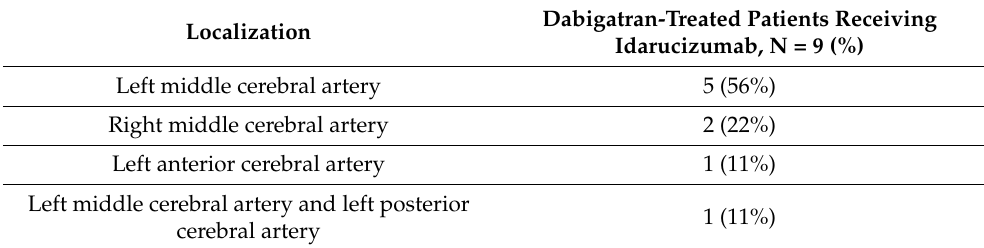
Table 2. Localization of ischemic stroke.